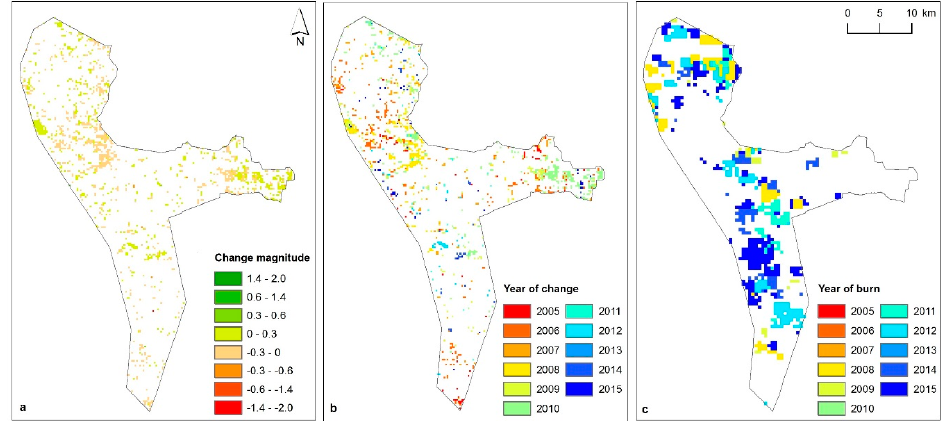
Figure 2. Change maps for the Aberdare National Park from 2005–2015 showing: ( a ) The magnitude of change in the MODIS Enhanced Vegetation Index (EVI) derived using Breaks For Additive Season and Trend (BFAST); ( b ) The year the breakpoint was detected by BFAST; ( c ) Areas of fire detected by the MODIS MCD451A product.